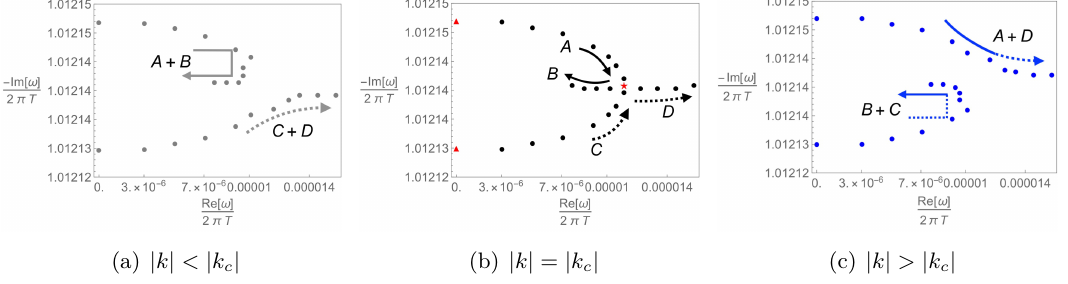
Figure 4 . Quasi-normal modes near | k c | /T at φ k ∈ [0 , 0 . 0000116] : | k |−| k c | = ( − 1 . 2 × 10 − 5 , 0 , 1 . 2 × 10 − 5 ) T (left, center,